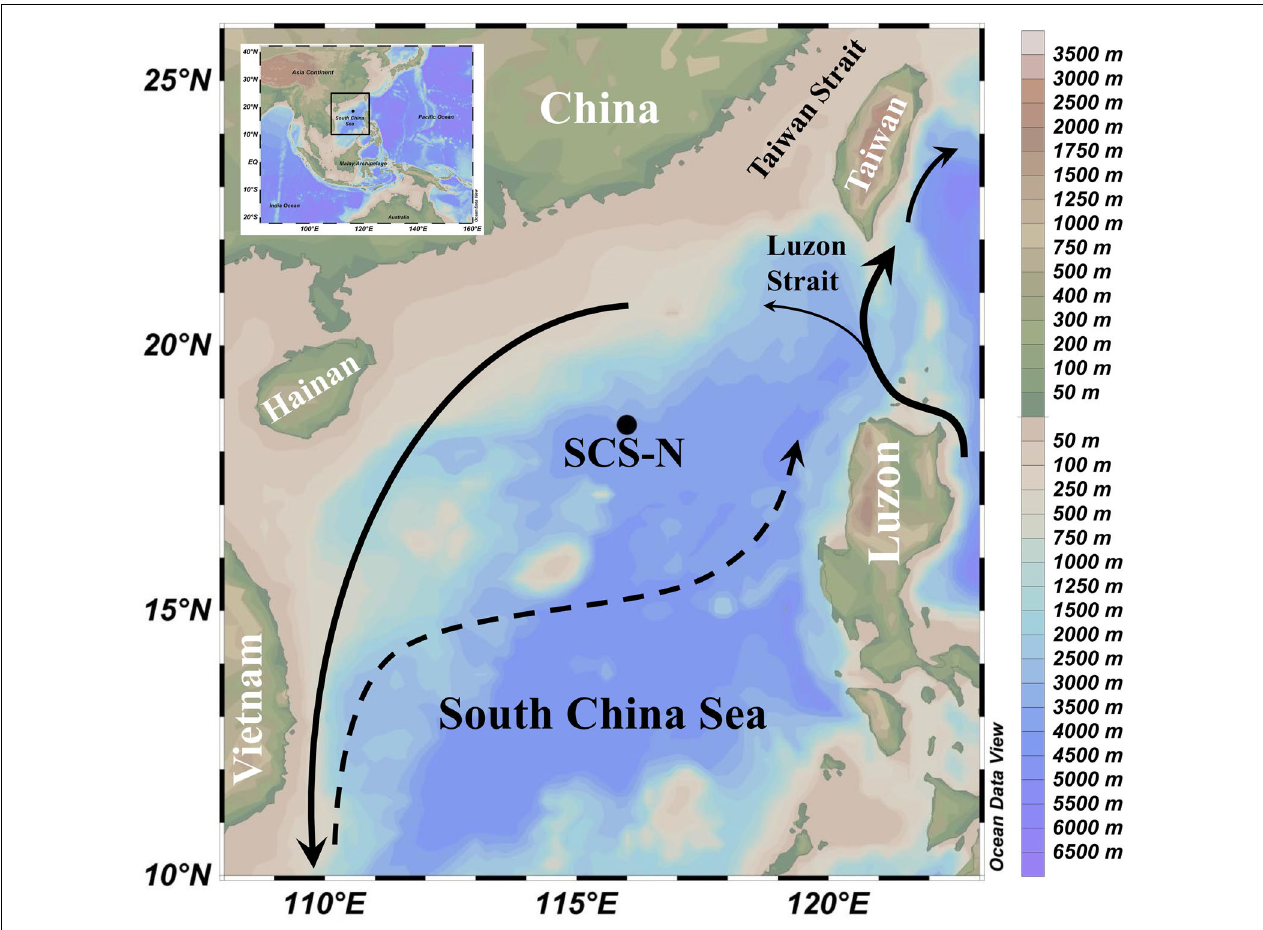
FIGURE 1 | Location of SCS-N sediment trap mooring station in northern SCS (116.0 ◦ E, 18.5 ◦ N). Solid line with arrow indicates basin-wide winter cyclonic gyre in northern SCS and Kuroshio with its intrusions around Luzon Strait. Dashed line represents eastward jet off the coast of Vietnam in summer. Overview map at upper left shows location of SCS, and black box represents the study